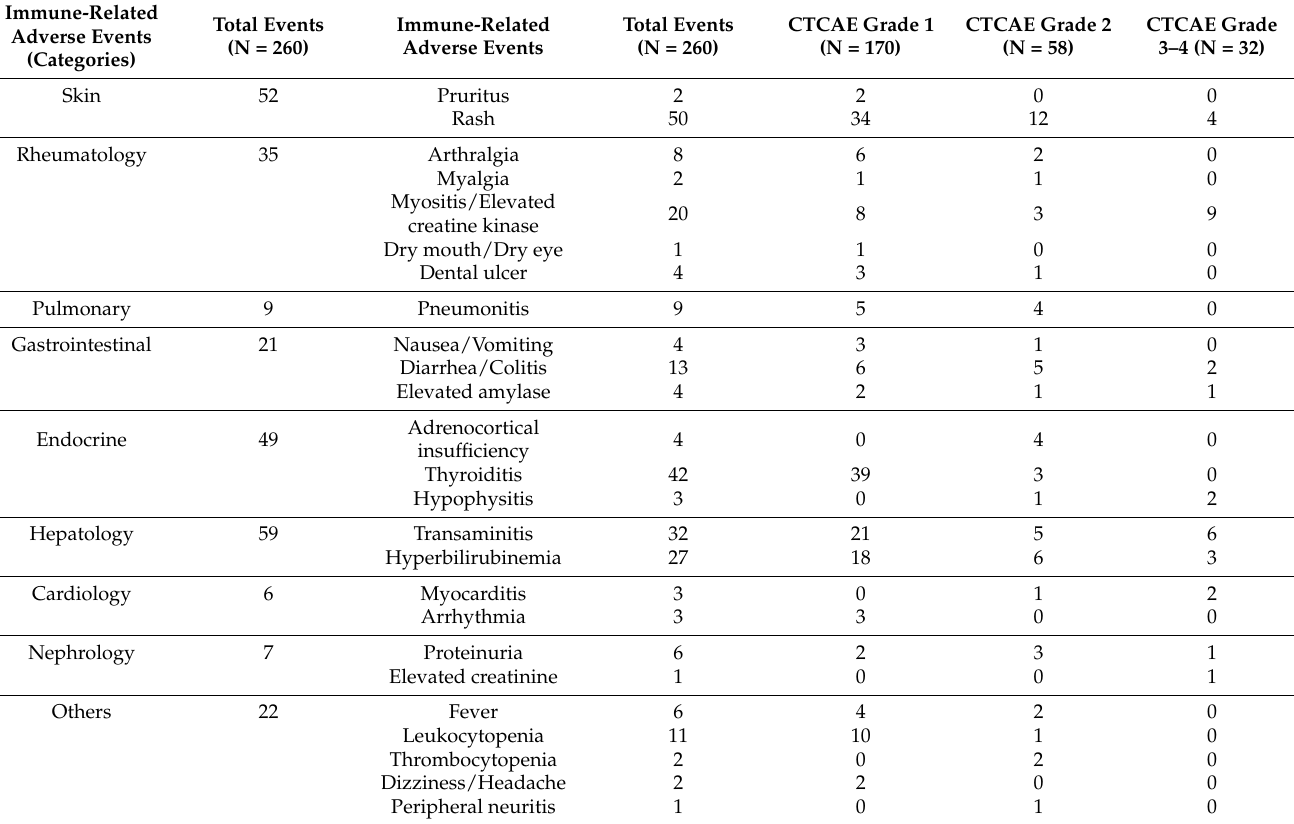
Table 2. Summary of immune-related adverse